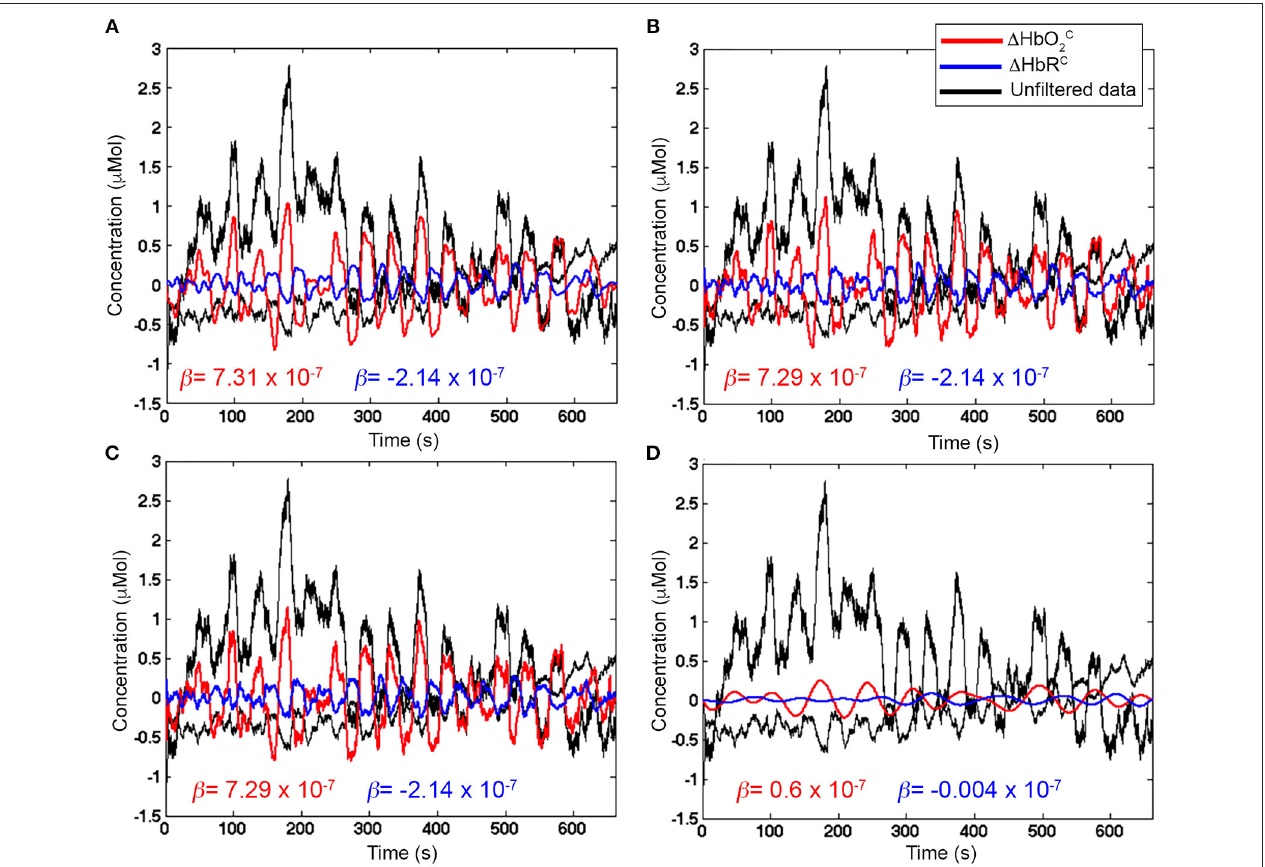
FIGURE 11 | Examples of filtered 1 HbO 2 (red) and 1 HbR (blue) signals with Amplitude 1 for one channel of a representative participant. Unfiltered 1 HbO 2 and 1 HbR are presented in black. β -values (in red for 1 HbO 2 and in blue for 1 HbR) are included as well. (A) shows properly filtered 1 HbO 2 and 1 HbR data (BP FIR filter, order = 1,000, F c = [0.01, 0.09] Hz) where the stimulation frequency (0.025Hz) is correctly included in the F c range, so that the hemodynamic response component is preserved and the β -values are the closest to the reference (8 × 10 − 7 for 1 HbO 2 and of − 2.7 × 10 − 7 for 1 HbR). (B,C) present filtered 1 HbO 2 and 1 HbR (BP FIR filter, order = 1,000) with wider passband ranges ( F c = [0.01, 0.6] Hz and F c = [0.01, 1.2] Hz, respectively) that let pass also unnecessary higher frequency noise (i.e., faster oscillations in the signals) that worsen the fit with the GLM approach. (D) , wrongly filtered 1 HbO 2 and 1 HbR data (BP FIR filter, order = 1,000, F c = [0.01 0.015] Hz) are presented, where the stimulation frequency (0.025Hz) is not included in the F c range, and the hemodynamic response component is strongly